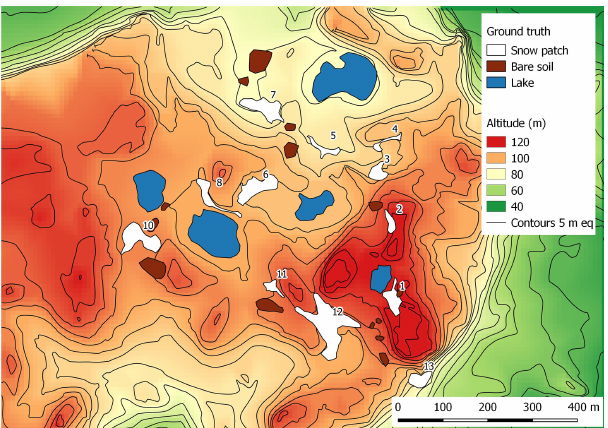
Figure 2. Topographical setting of the Meseta Norte test area on Fildes Peninsula with the ground truthing mapped in the field. Snow patches are numbered as in the